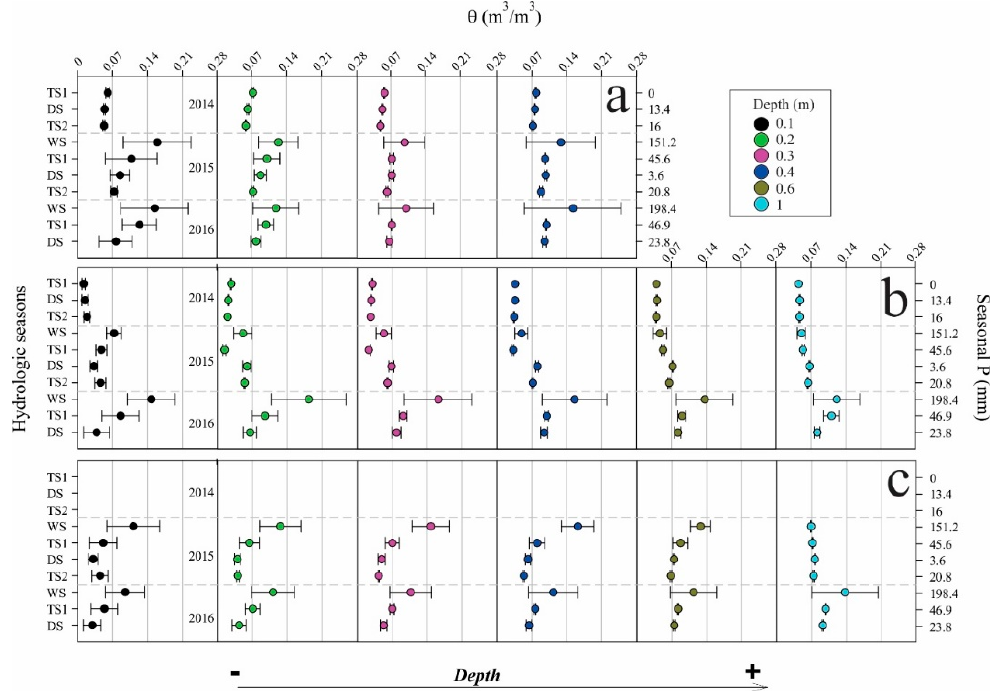
Figure 6. Relation of seasonal evolution of average θ in the hydrological seasons at different depths and the seasonal precipitation at sites: ( a ) SFS, ( b ) CT and ( c ) NFS. The horizontal dashed lines represent the boundary between the hydrological years and the lines in the circles represent the seasonal standard deviation.